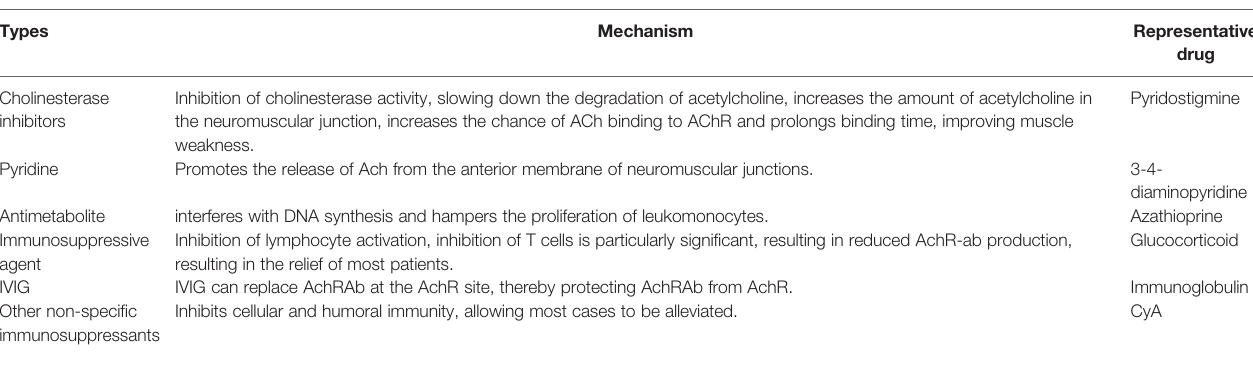
TABLE 1 | Traditional medicine for